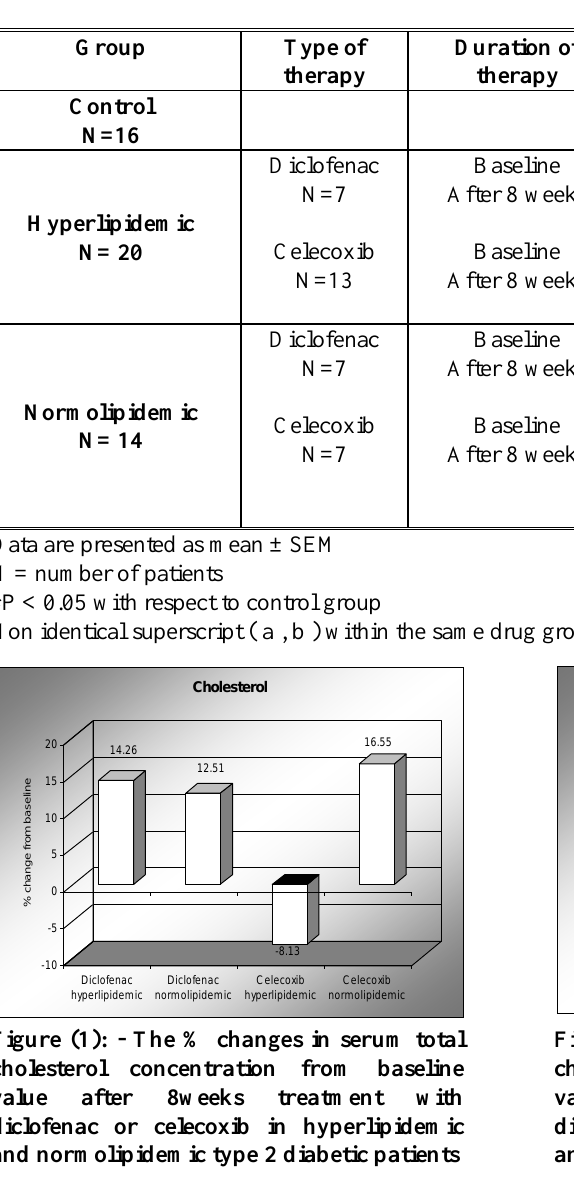
Table (2): Effect of treatment with diclofenac or celecoxib on lipid ratios (LDL/HDL) , (TG/HDL) in normolipidemic and hyperlipidemic type 2diabetics Type of therapy